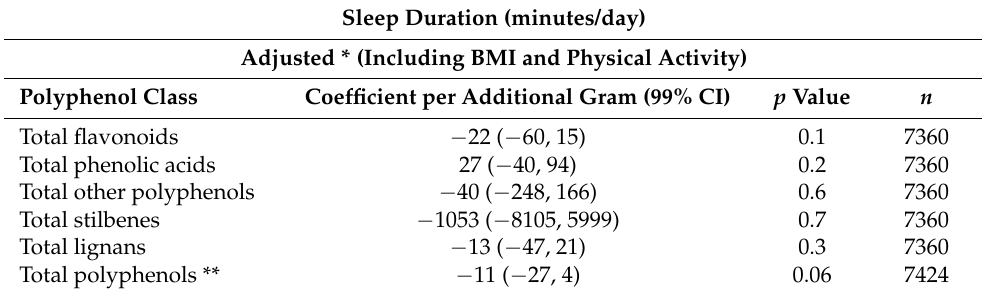
Table A7. Prospective associations between polyphenol content from fruit and vegetable intakes and sleep duration for women from the UKWCS after further adjusting for BMI and physical activity.